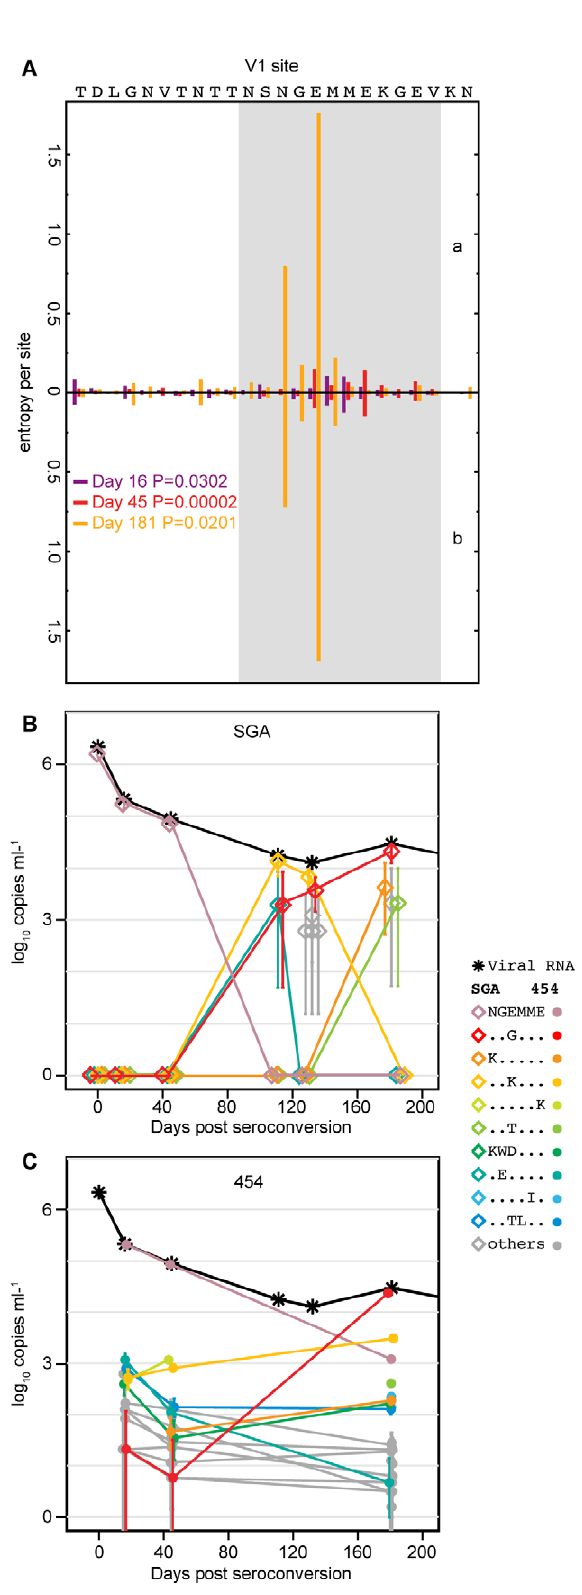
Figure 7. Sequence entropy and viral dynamics at the CH40 V1 Nab epitope. (A) 454 sequence entropies inside (grey) and outside (white) of a 12-amino acid Nab epitope region in V1. Bar length indicates Shannon entropy computed bidirectionally (a and b) (one- sided Wilcoxon analysis). (B and C) Plasma viral RNA (black